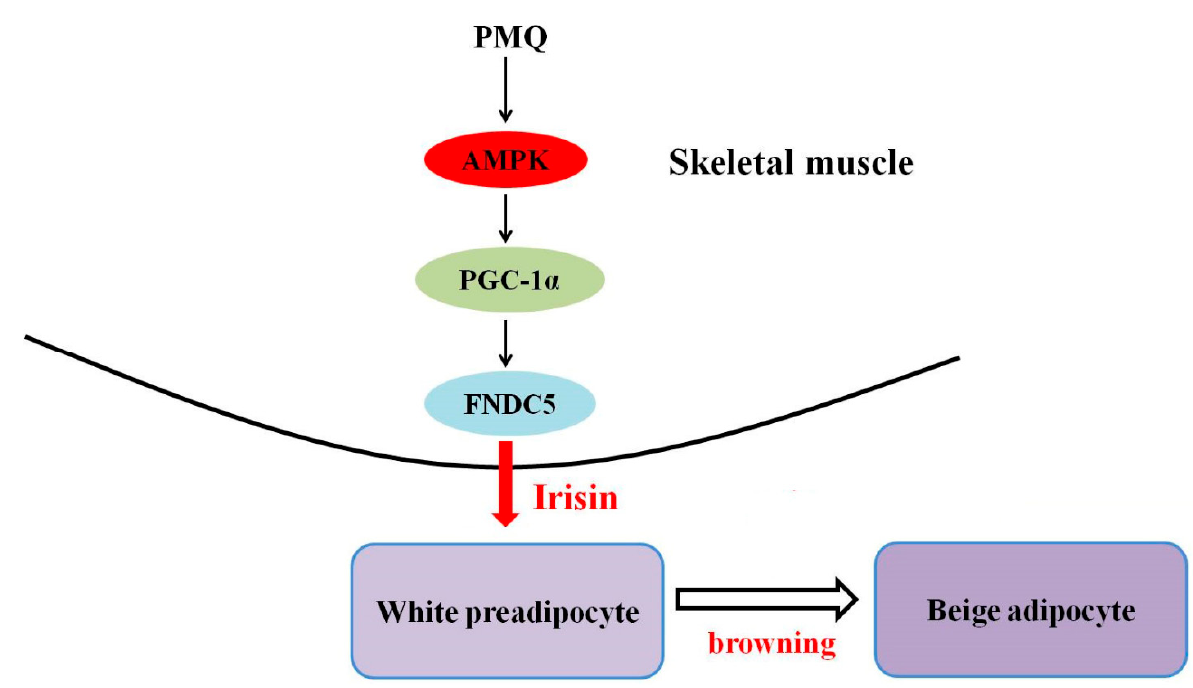
Figure 8. Schematic diagram of molecular mechanism of PMQ on driving browning of WAT. Supplementary Materials: The following supporting information can be downloaded at: www.mdpi.com/xxx/s1, Figure S1: PMQ reduces obesity and improves insulin sensitivity.; Figure S2: PMQ promotes the browning of inguinal WAT in MSG mice; Figure S3: Experimental scheme for myotube-conditioned media treatment on 3T3-L1 adipocytes; Figure S4: Conditioned media from PMQ-treated myotubes induce brown-like transition in 3T3-L1 cells; Table S1: primer sequence.